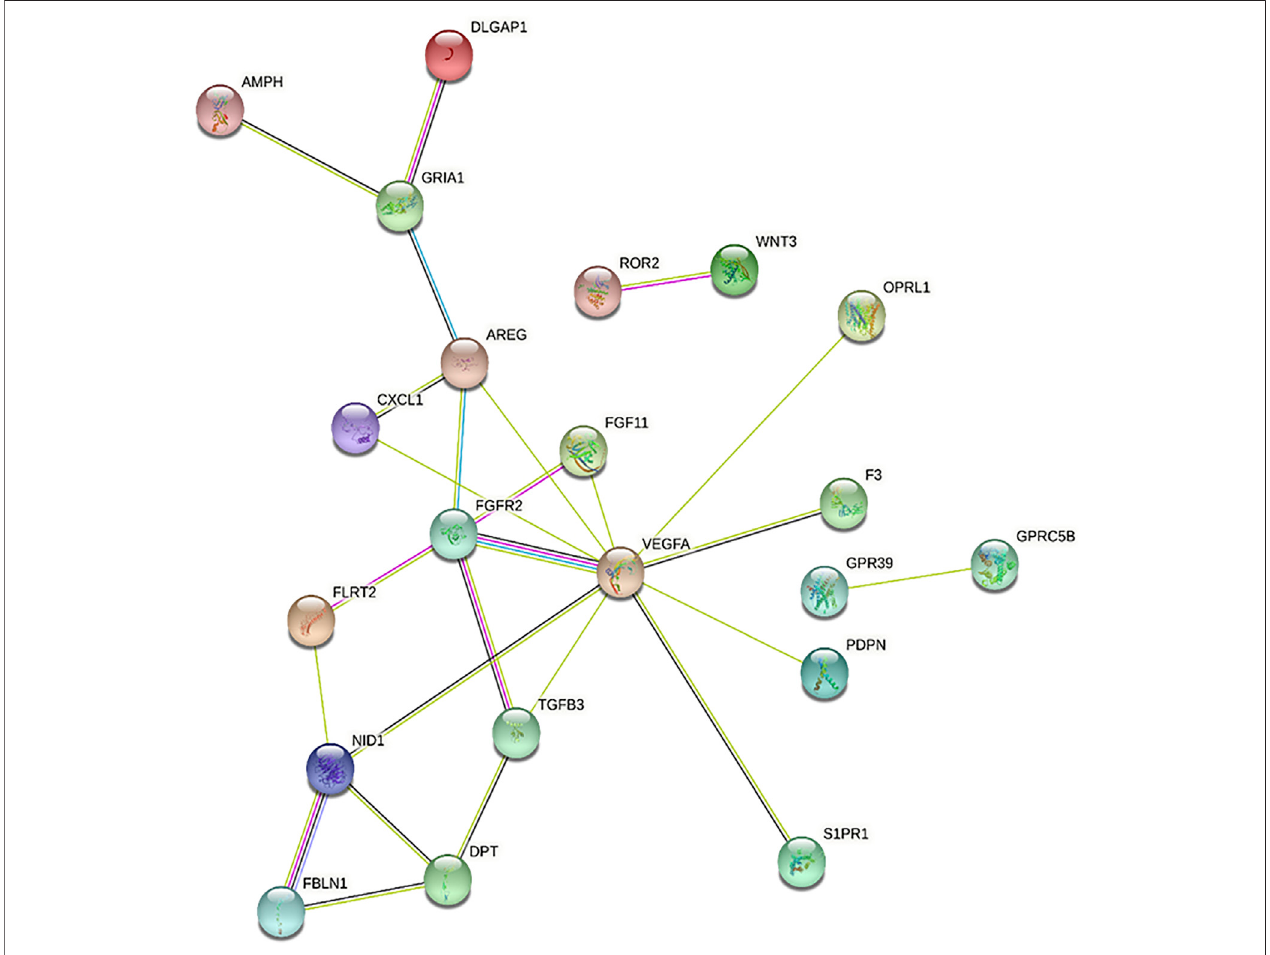
FIGURE4 | Protein-protein interactionnetworkamong genesdownregulated by 1nM T3, aspredictedusing STRING. Genesthat are central tothe network, such as VEGFA , FGFR2 and TGFB3 , are associated with biological processes enriched by this treatment, as shown in Table 2 .